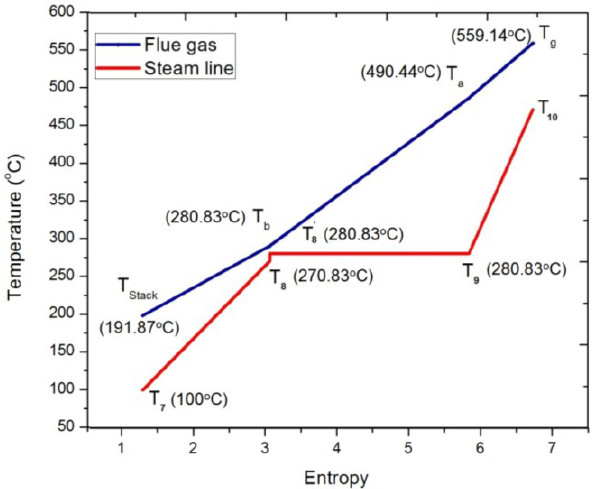
Figure 3. Temperature-Entropy ( T - S ) diagram of Heat Recovery Steam Generator